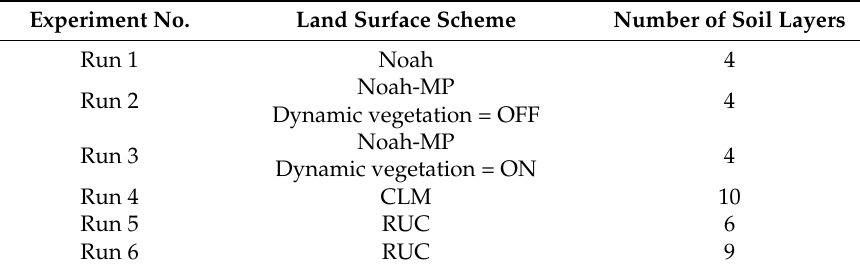
Table 1. Description of the six performed